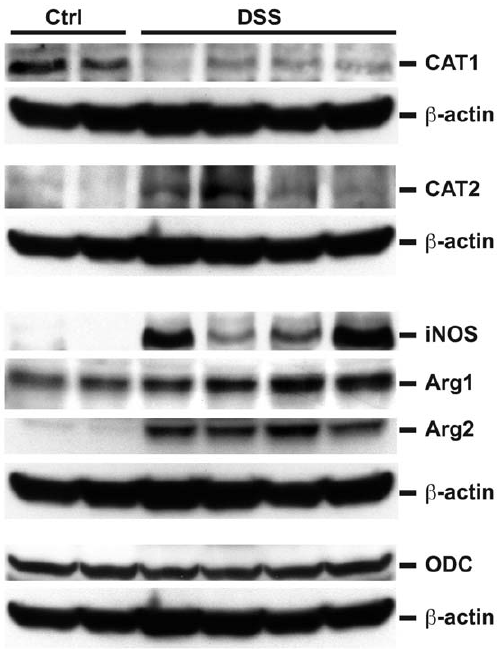
Figure 3. DSS-induced colitis alters L-Arg metabolic pathway protein levels. 7-week-old C57BL/6 mice received 4% DSS in the drinking water or water alone (Ctrl) for 7 days. At sacrifice on day 7, the colon was removed and tissues were obtained for protein isolation and assessment by Western blotting. Each lane represents a different mouse. There were two separate blots that were used, so the appropriate b -actin housekeeping gene control is placed under the blots for the proteins of interest that were performed on those same membranes.